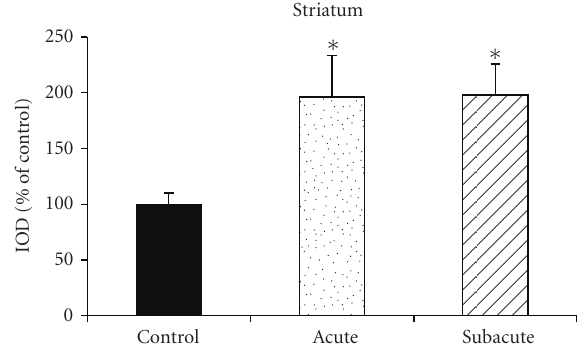
Figure 1: Expression of NMDAR1 in striatum. Data are integrated optical density of NMDAR1 immunoreactivity band, normalized to β -actin levels, and expressed as percentage of the control group. Values represent mean ± S.E.M ( n = 5–7). ∗ P < . 05 in comparison with the control group by one-way ANOVA with Dunnett post-hoc